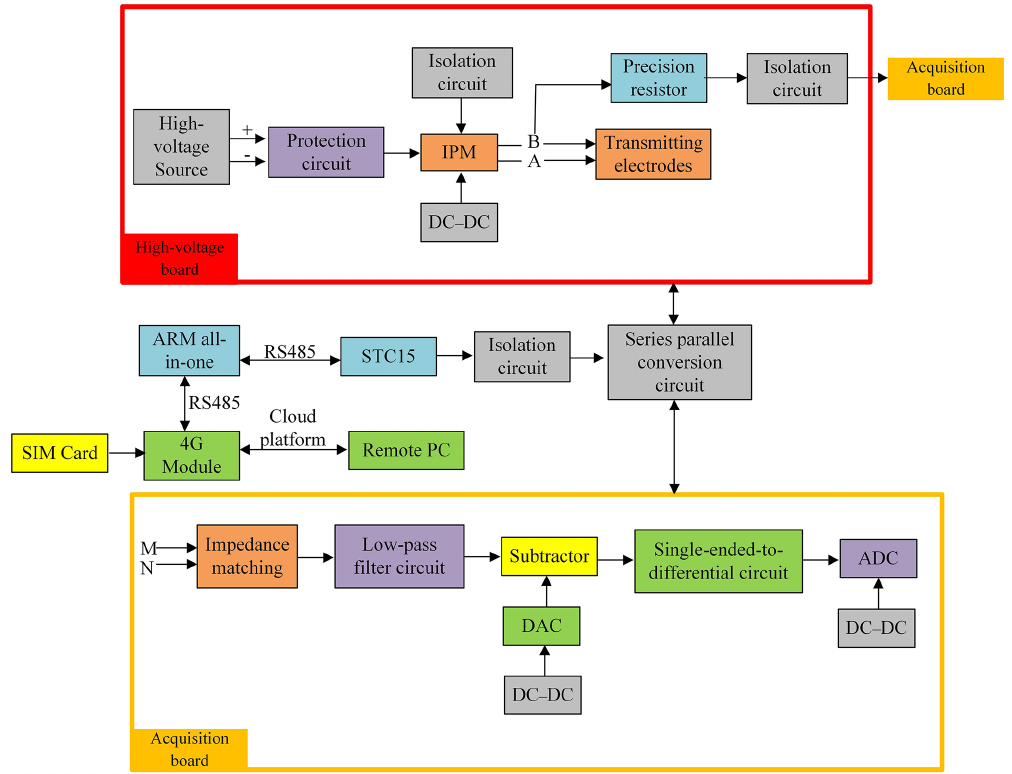
Figure 3. High-level architecture of the 4D high-density electrical instrument based on IoT.